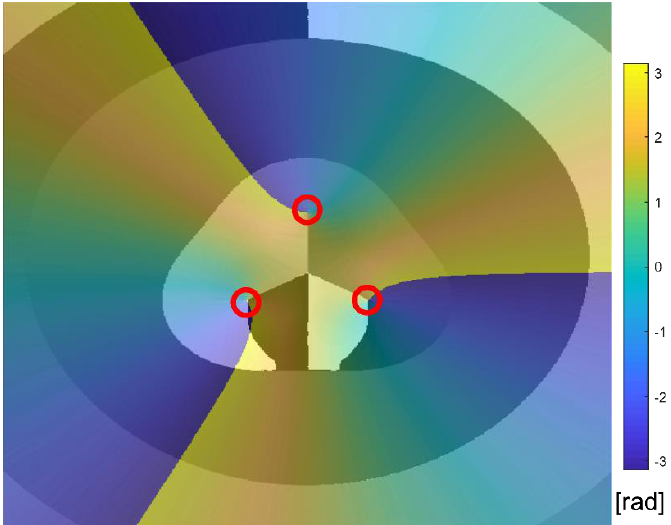
Figure 5. Pseudo-phase, plotted as arg(𝐼 𝑐𝑜𝑛 (𝑟, 𝜃)) for the vortex beam with a topological charge of m = 3 after separation into three vortices with topological charges of m = 1, with the original phase map colored and superimposed. The red circles indicate the locations of vortex points on both types of maps.